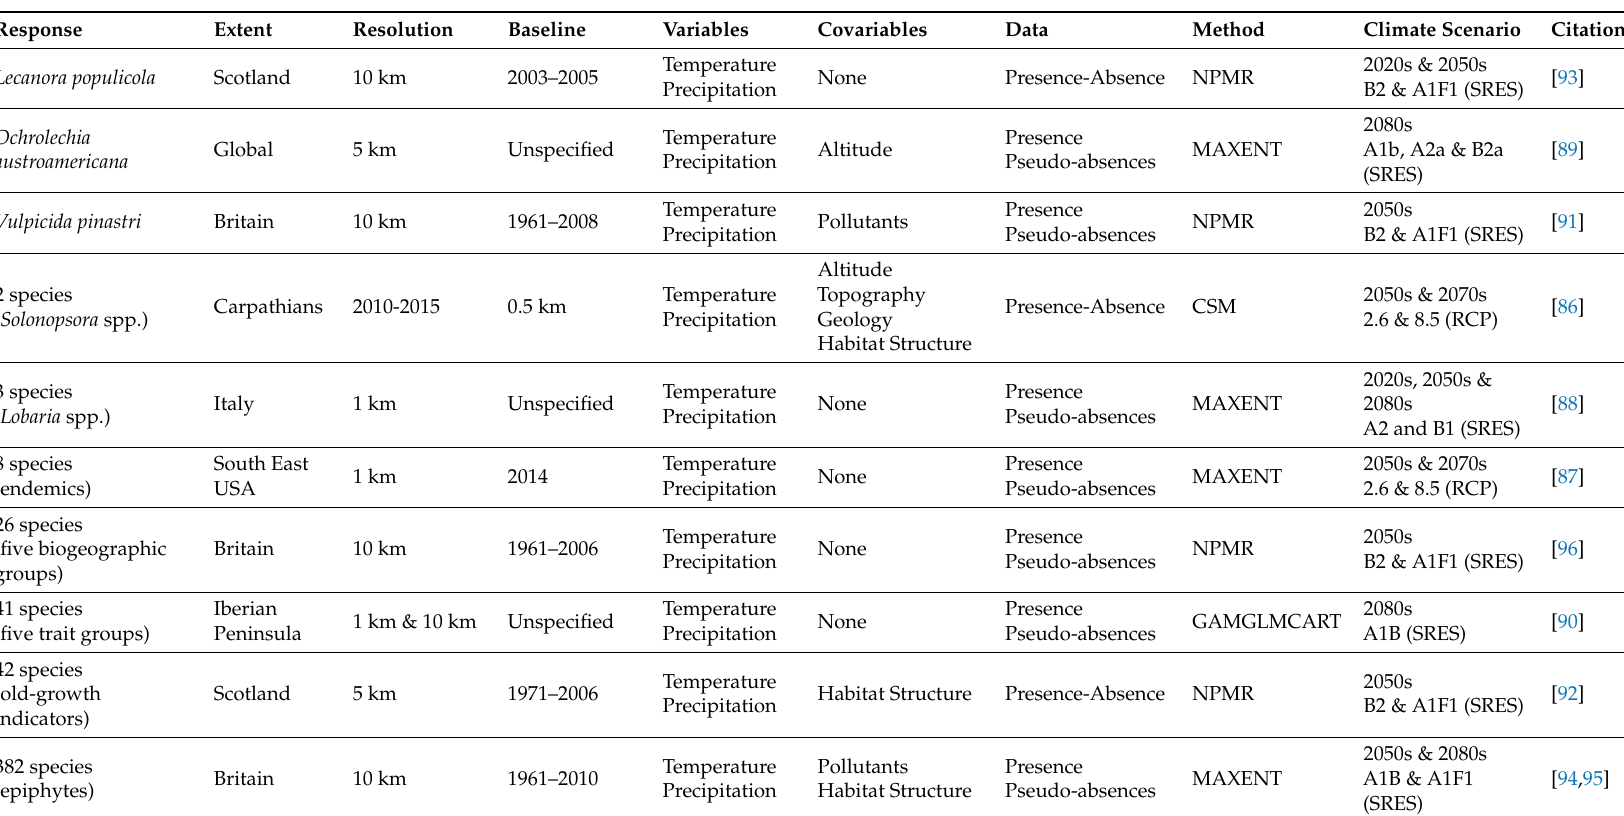
Table 2. Examples of bioclimatic modelling studies on lichens, investigating response to both the baseline and climate change scenarios. The list is not exhaustive and is drawn primarily from the Web of Science Core Collection under the Boolean search terms for a period 1990–2018: ‘lichen AND climat* AND model* AND (bioclimat* OR species distribution OR habitat suitability)’. Examples are further restricted to studies that use distributional data to understand the response of individual lichens (mycobiont and photobiont in symbiosis), as opposed to community response (composition/richness) or functional